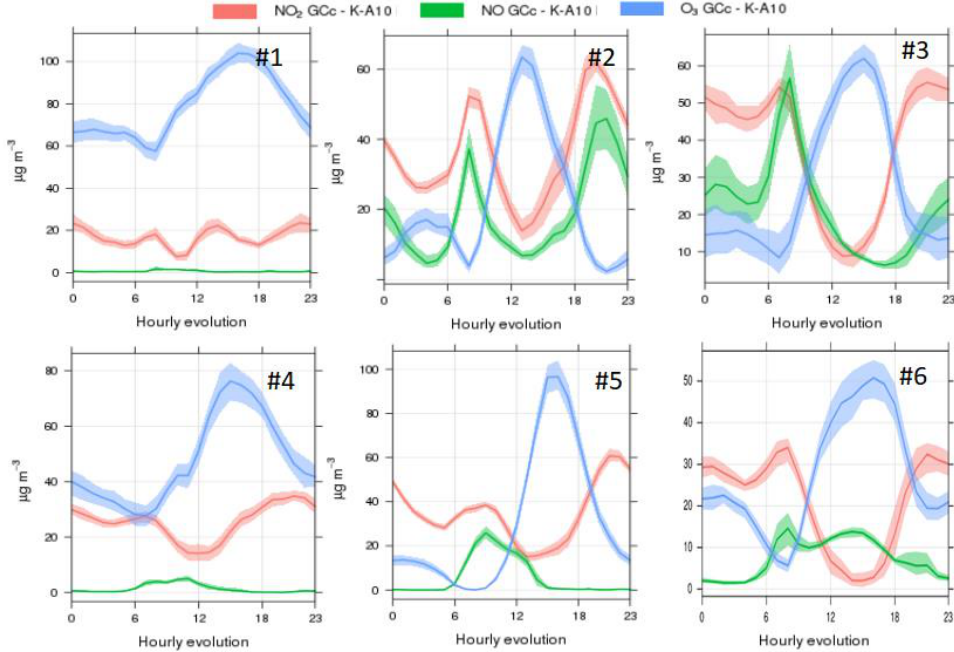
Figure 1. Mean daily evolution of gaseous pollutants NO 2 , NO and O 3 for the months July–September 2019, for the 6 stadia in major cities in: #1: Europe, #2: Africa, #3: Oceania; #4: Asia; #5: America; #6: Africa (data from October–December 2020).